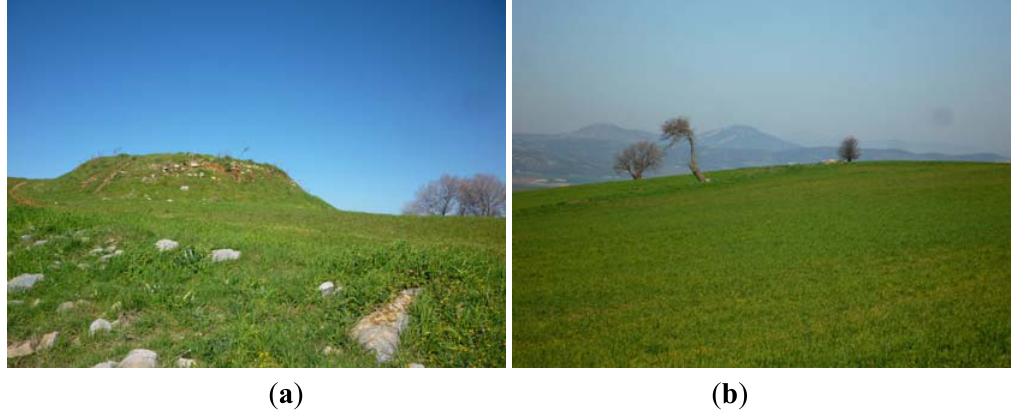
Figure 7. Photos from two magoules located in the Thessalian plain: ( a ) Zerelia site and ( b ) Karatsantagli site.